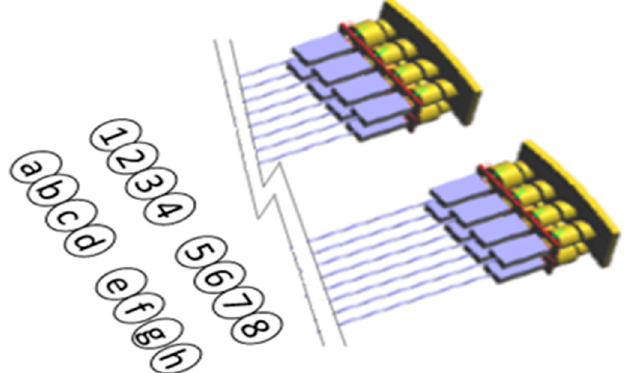
Figure 6. Assembly schematic of the 3D digital optical headlight system, with laser source numbering. 2, 3, 4, 5, 6, 7, 8, e, f, total nine diodes are designed and optimized for low beam; compared to low beam, eight (a, b, c, d, e, f, g, h) is designed and optimized for high beam. More laser diodes is employed